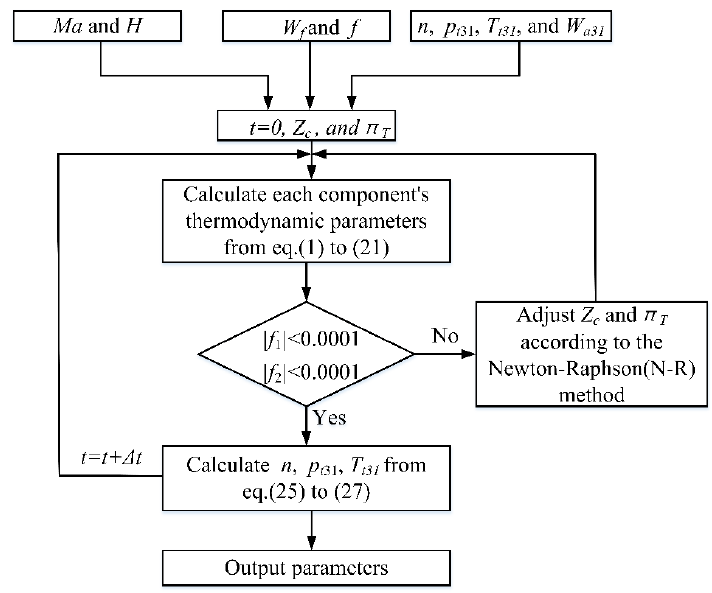
Figure 2. The solving process of the PDTE model.